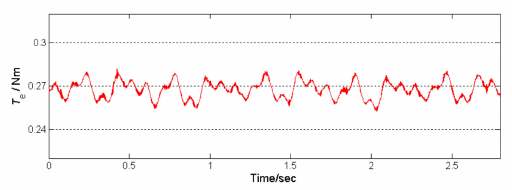
Figure 20. Electromagnetic torque of proposed method.